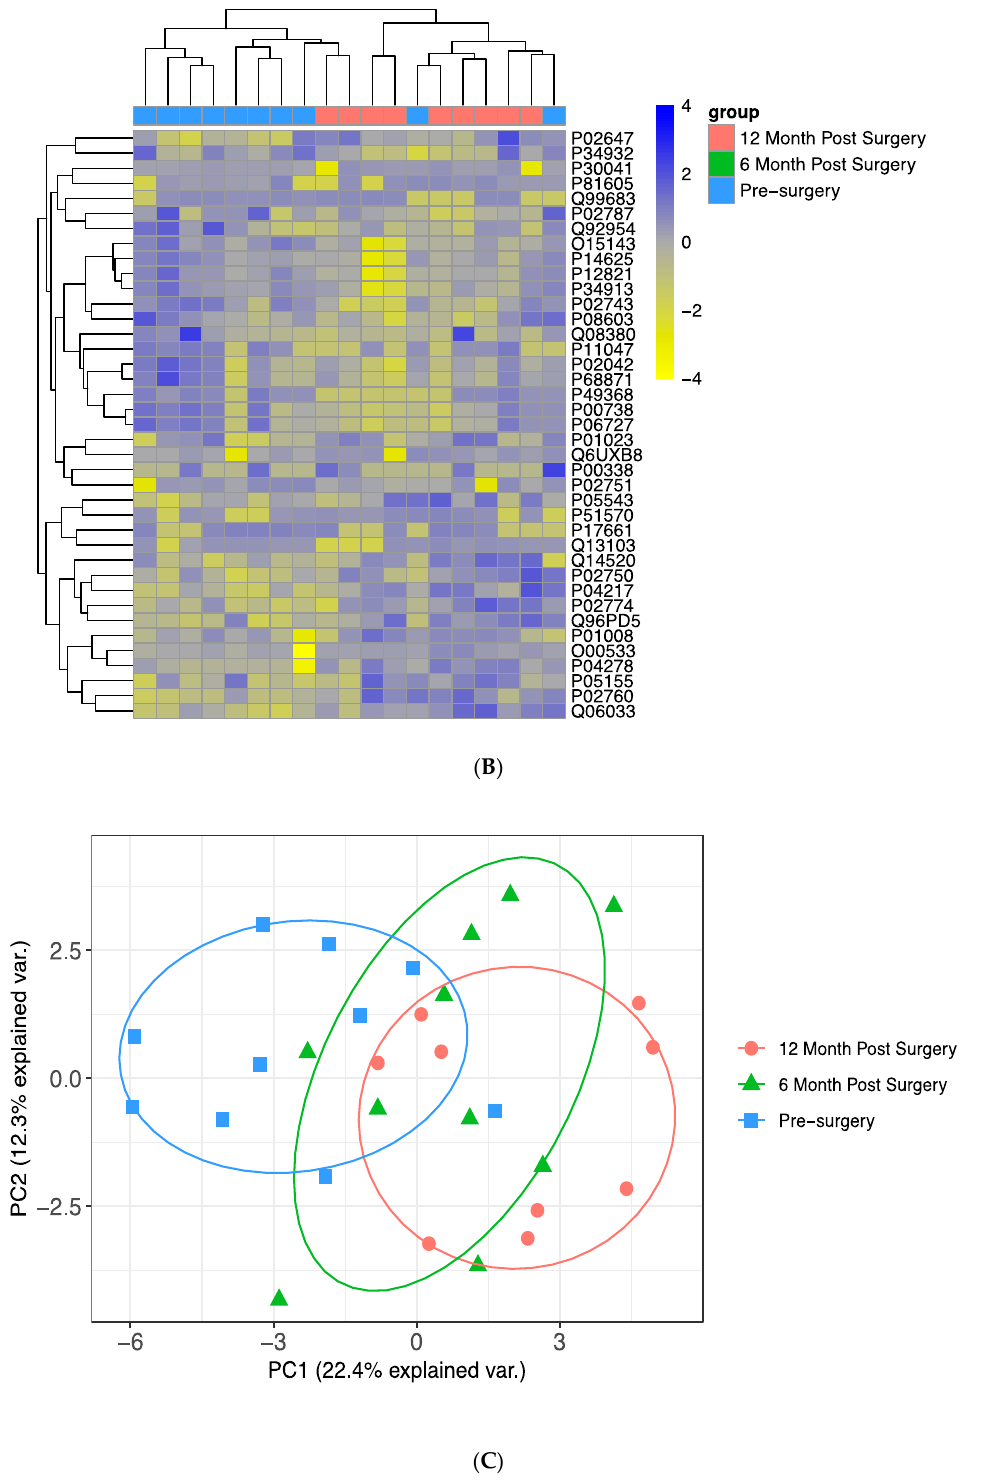
Figure 3. Protein abundance changes 12 months post-surgery. ( A ) Volcano plot: green points are significant and have a fold change > 1, red points are significant but have a fold change < 1 and black points are not significant. ( B ) Hierarchical clustering and heatmap of all 39 proteins significantly different 12 months post-surgery relative to pre-surgery samples. Hierarchical clustering was performed using the Euclidean distance. Row scaling was performed on the log2 abundance for each protein by the subtraction of the mean from each feature and then dividing by the standard deviation. ( C ) Principal component analysis with all 39 proteins significantly different 12 months post-surgery relative to pre-surgery